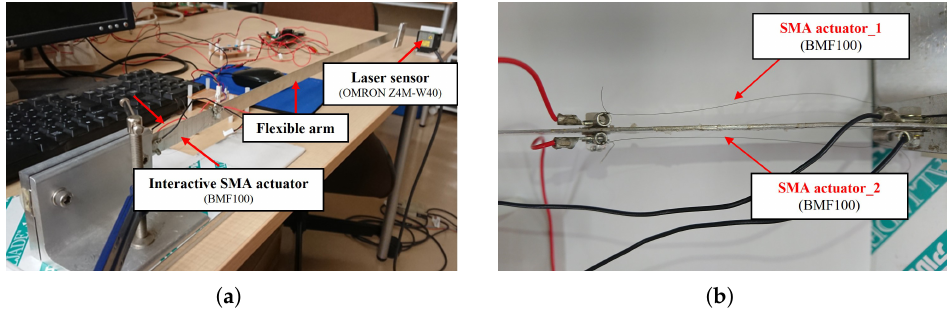
Figure 1. Configuration of the experimental setup. ( a ) The flexible arm. ( b ) Interactive SMA actuation.